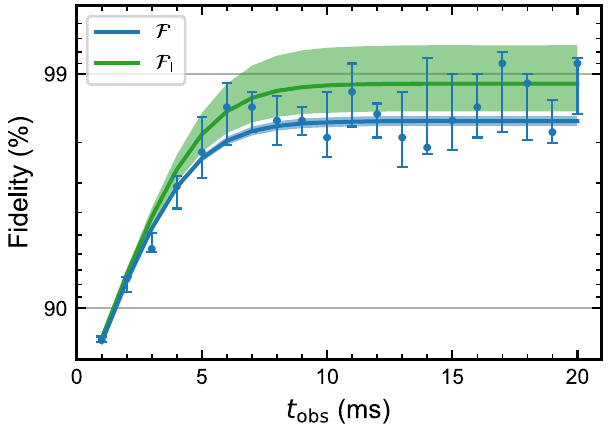
FIG. 4. The j ↓ i population increases with increasing observa- tion time. The median experiment fidelity F is shown by the blue points with corresponding line of best fit to Eq. (8) (the blue shaded region indicates one standard deviation model uncer- tainty). The initialization fidelity F I is shown by the green line of best fit (one standard deviation model uncertainty indicated by the shaded green